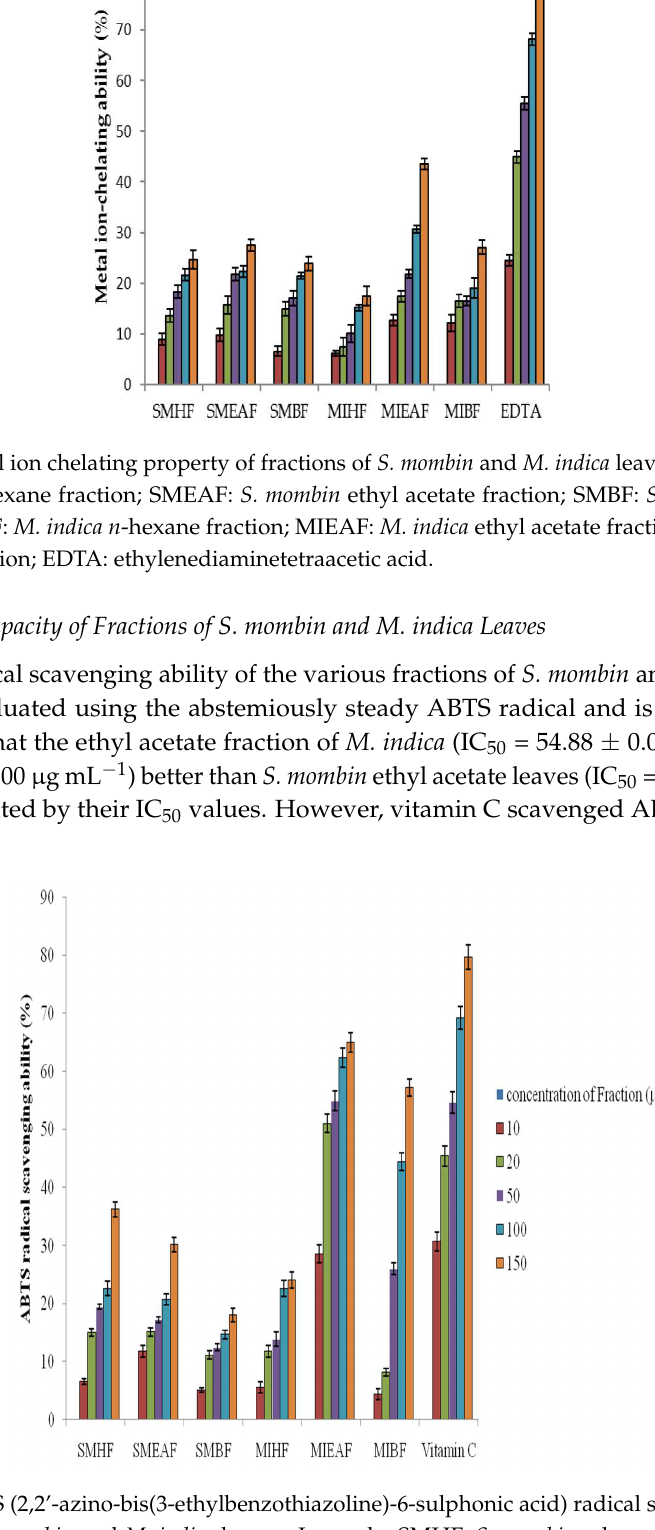
Figure 4. ABTS (2,2’-azino-bis(3-ethylbenzothiazoline)-6-sulphonic acid) radical scavenging ability of fractions of S. mombin and M. indica leaves. Legends: SMHF: S. mombin n -hexane fraction; SMEAF: S. mombin ethyl acetate fraction; SMBF: S. mombin n -butanol fraction; MIHF: M. indica n -hexane fraction; MIEAF: M. indica ethyl acetate fraction; MIBF: M. indica n -butanol fraction.